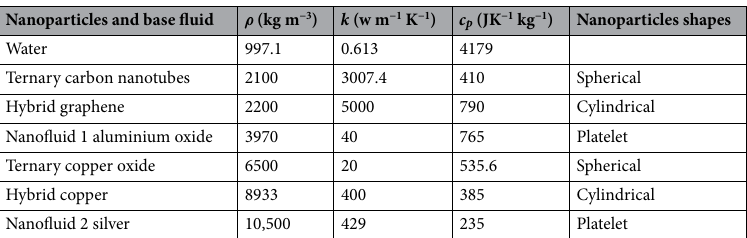
θ ′ ( 0 ) with Elnaqeeb et al. 56 for a limiting case. −